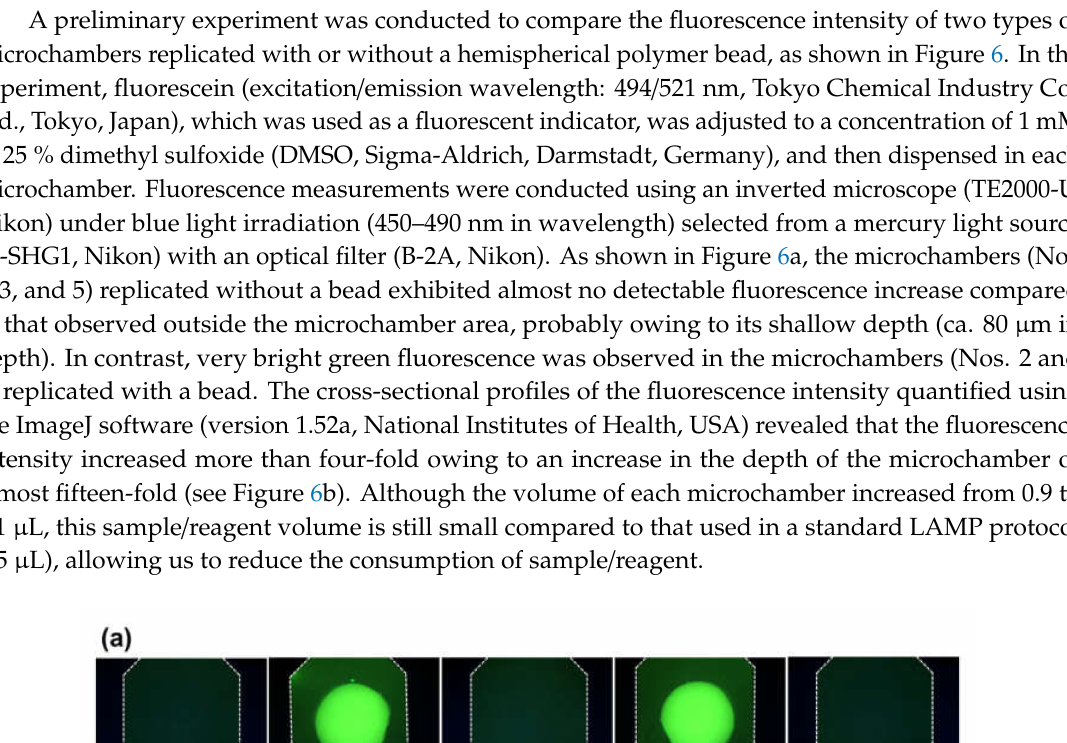
Figure 5. Optical microscopy images showing ( a ) close-up plane and ( b ) cross-sectional views of a PDMS reaction chamber precisely replicated from a hemispherical polymer bead glued on the SU-8 pattern.